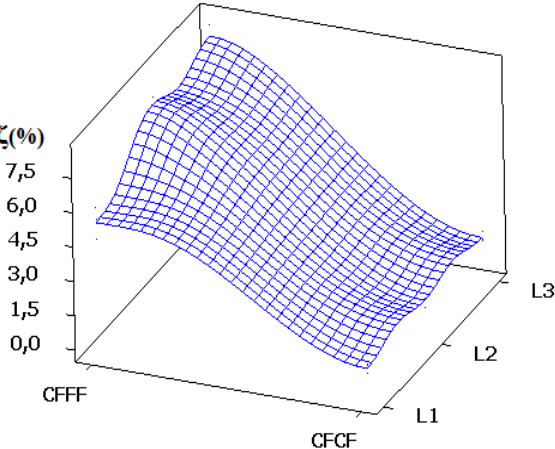
Figure 7. Effect of boundary conditions and attached mass locations on damping